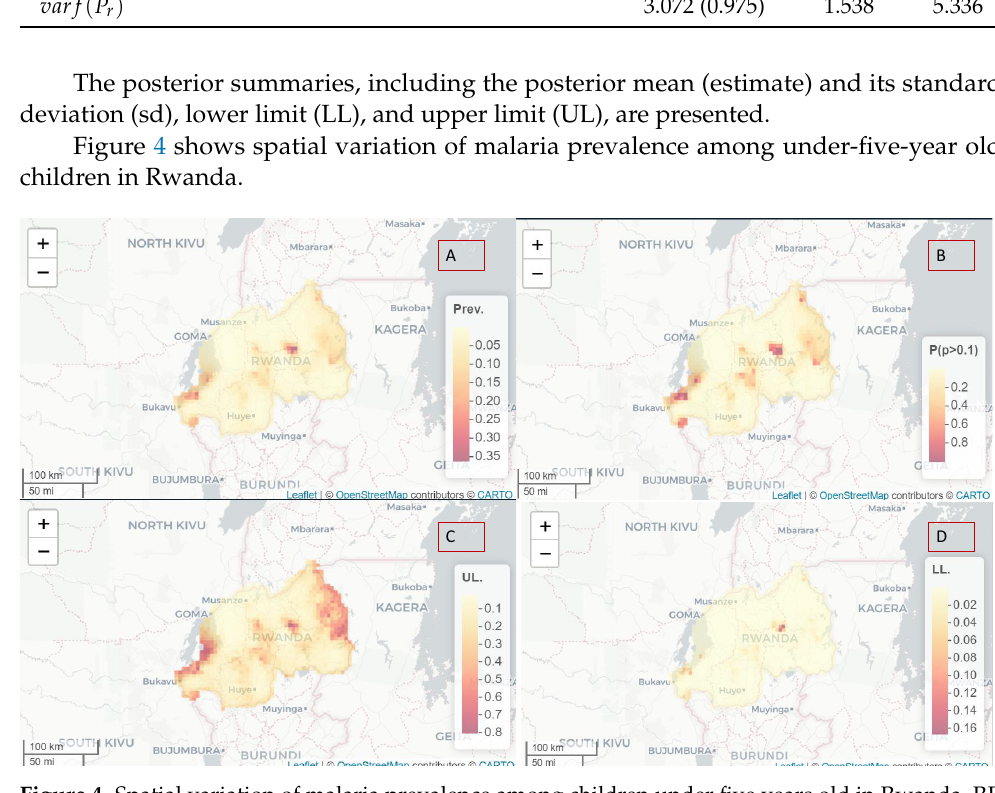
Figure 4. Spatial variation of malaria prevalence among children under five years old in Rwanda, RR posterior means of spatial effects ( A ) with 95% UL upper limit ( C ). Lower limit ( D ). Panel ( B ) shows exceeding probability of prevalence above 10% ( B ). Source: DHS